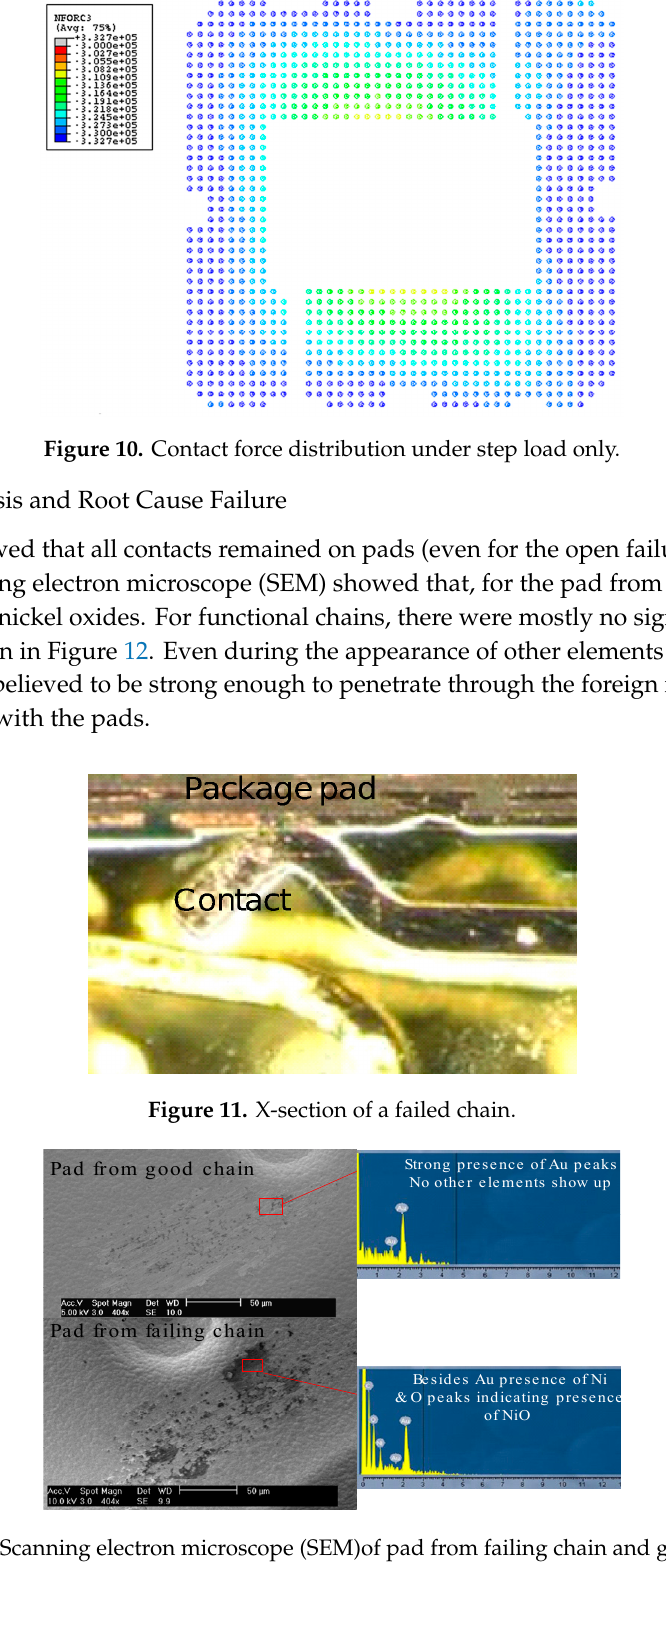
( b ) Figure 8. Selected